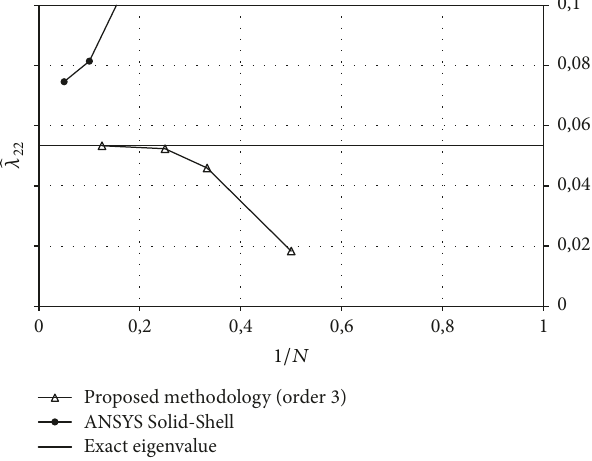
̂𝜆 1/𝑁 ( ℎ -conver- 22 versus